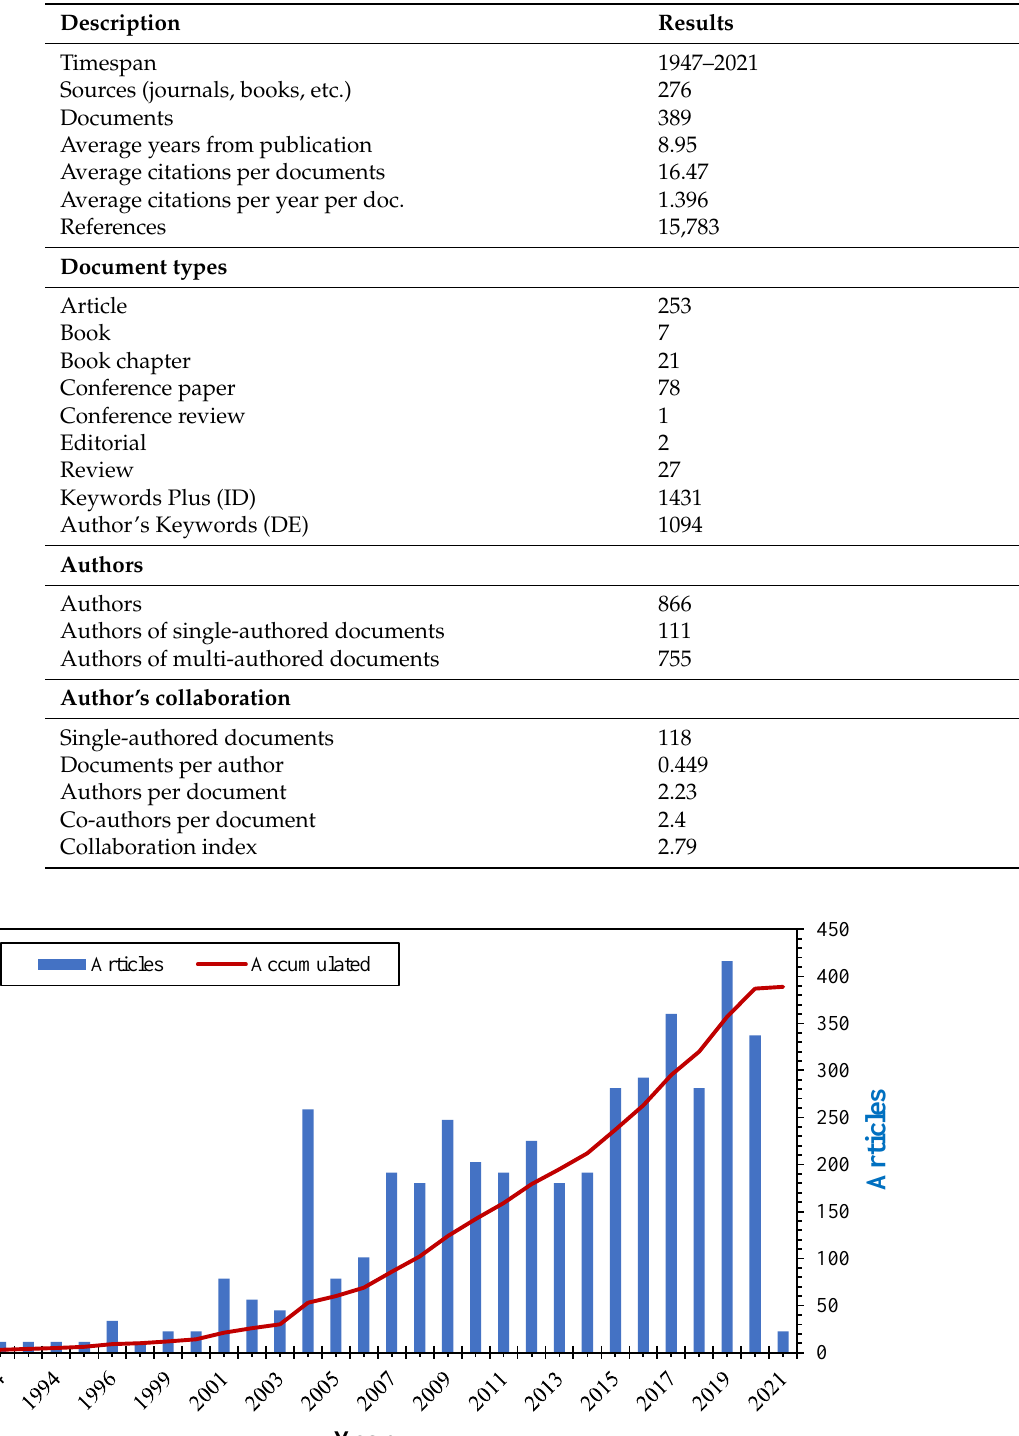
Table 2. Main information about the data analyzed.